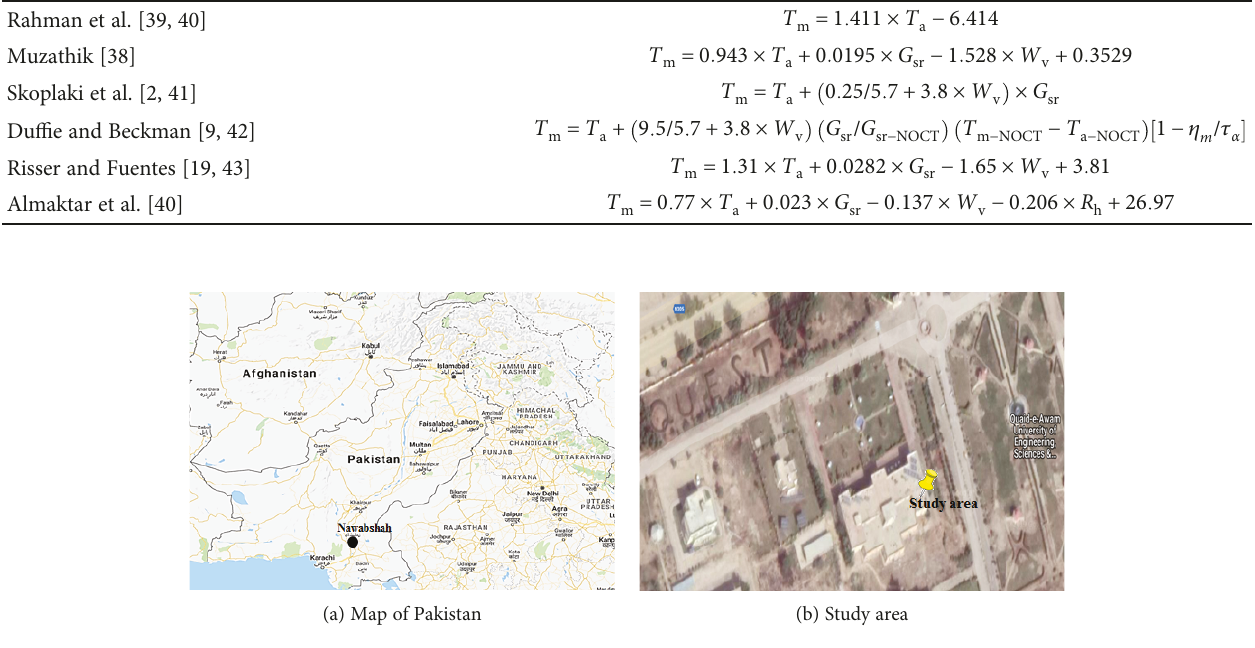
Figure 1: Geographical location of the study area (Google Maps). Table 2: Electrical characteristics of examined photovoltaic modules [14,